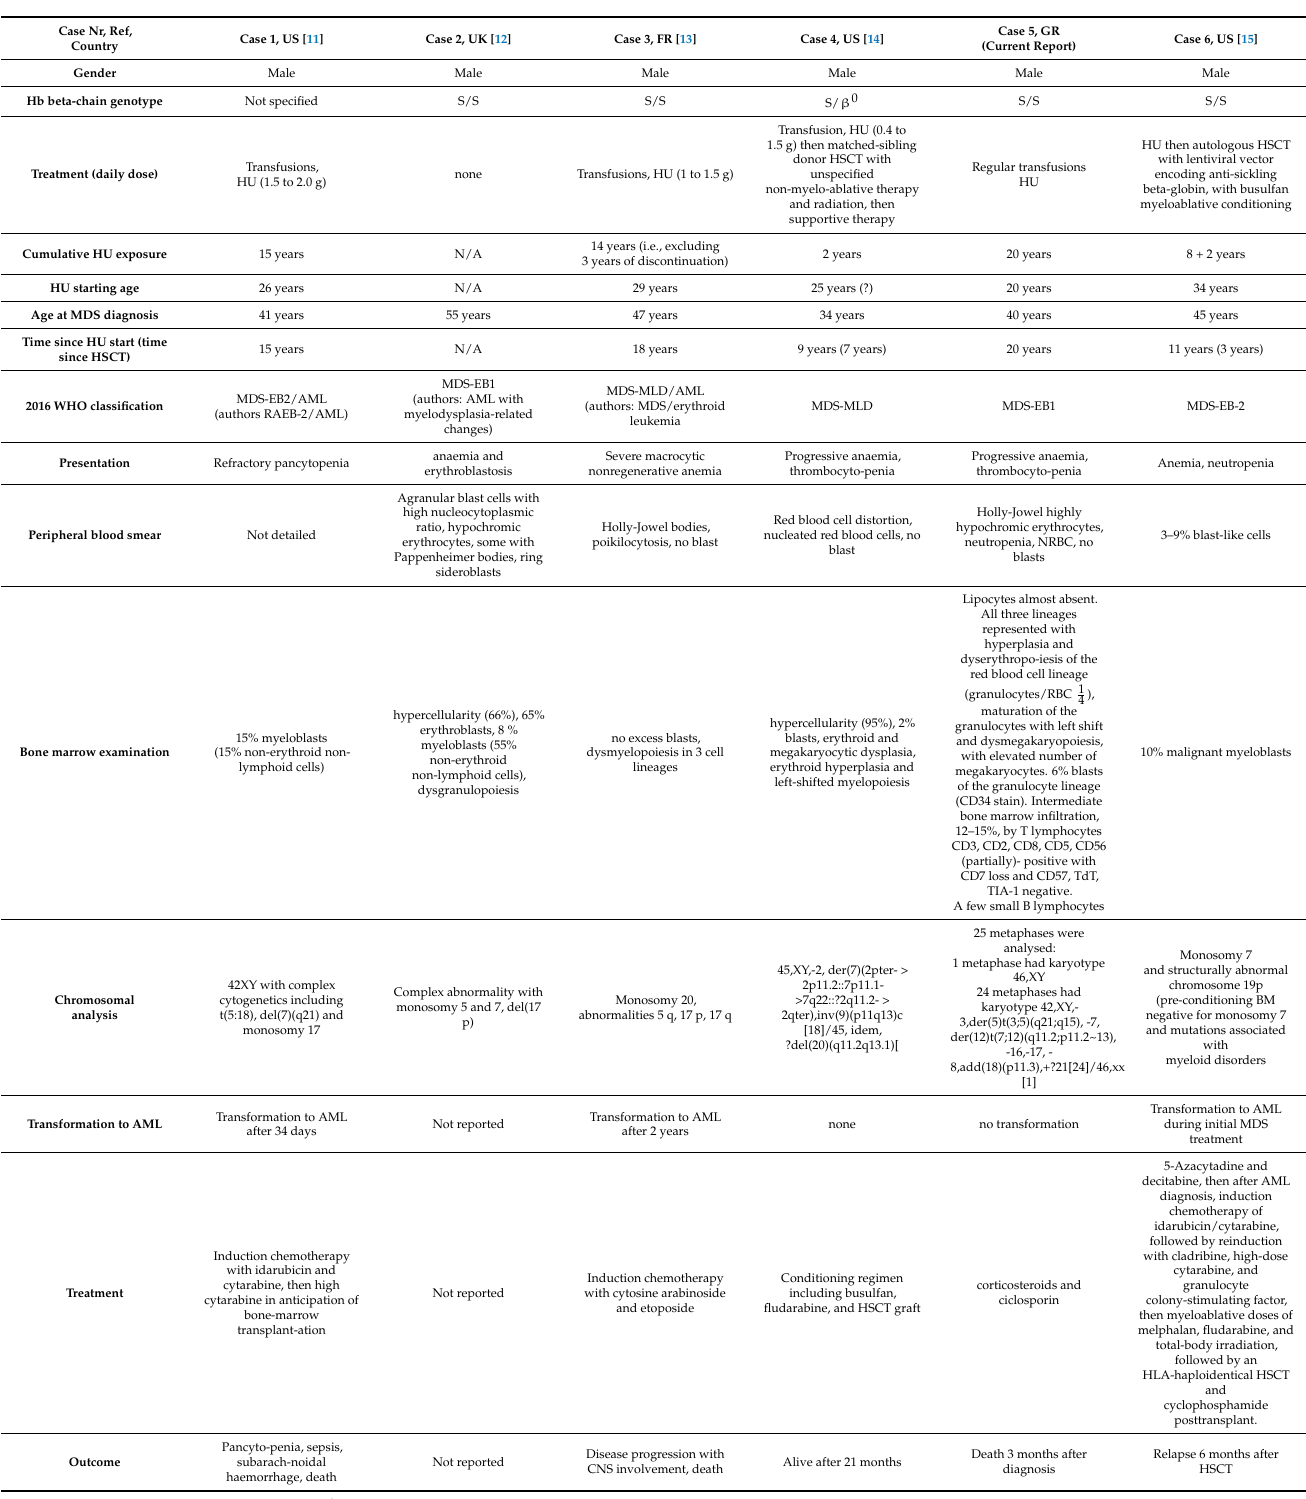
Table 1. Pathological features of MDS (past and present case)–only MDS according to the WHO 2016 classification were included (i.e., not including cases of MDS/MPN) &